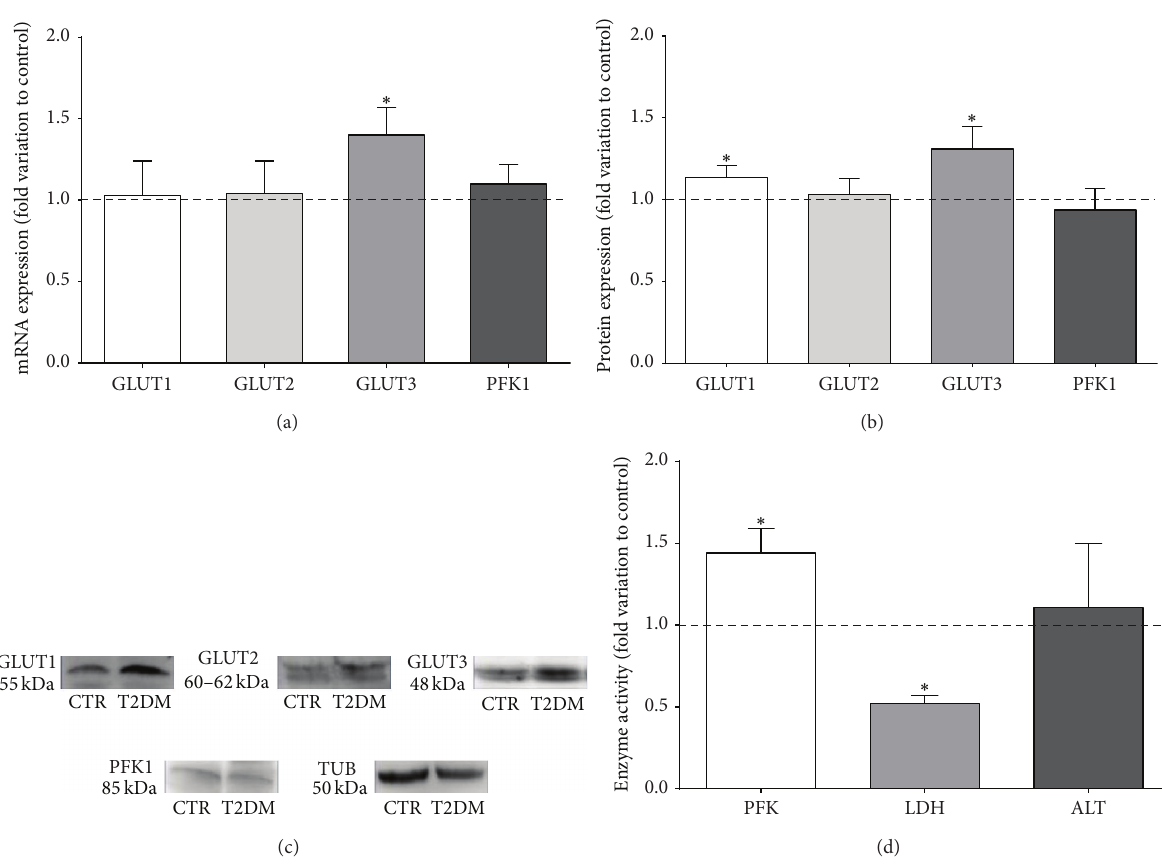
Figure 2: Type 2 diabetes mellitus (T2DM) modulates the (a) mRNA, (b) protein levels, and (d) activity of glycolytic enzymes and transporters. (a) Pooled data of independent experiments, indicating the fold variation of glucose transporters (GLUT1, GLUT2, and GLUT3) and of phosphofructokinase 1 (PFK1) mRNA levels found in testicles of T2DM rats when compared with the control rats (dashed line). (b) Pooled data of independent experiments, indicating the fold variation of GLUT1, GLUT2, GLUT3, and PFK1 protein levels found in testicles of T2DM rats when compared with the control rats (dashed line). (c) Illustrative Western Blot experiment. (d) Pooled data of independent experiments, indicating the fold variation of PFK1, lactate dehydrogenase (LDH), and alanine transaminase (ALT) enzymatic activities in testicles of T2DM rats when compared with the control rats (dashed line). Results are expressed as mean ± SEM ( 𝑛 = 6 for each condition). *Significantly different relative to control ( 𝑃 < 0.05